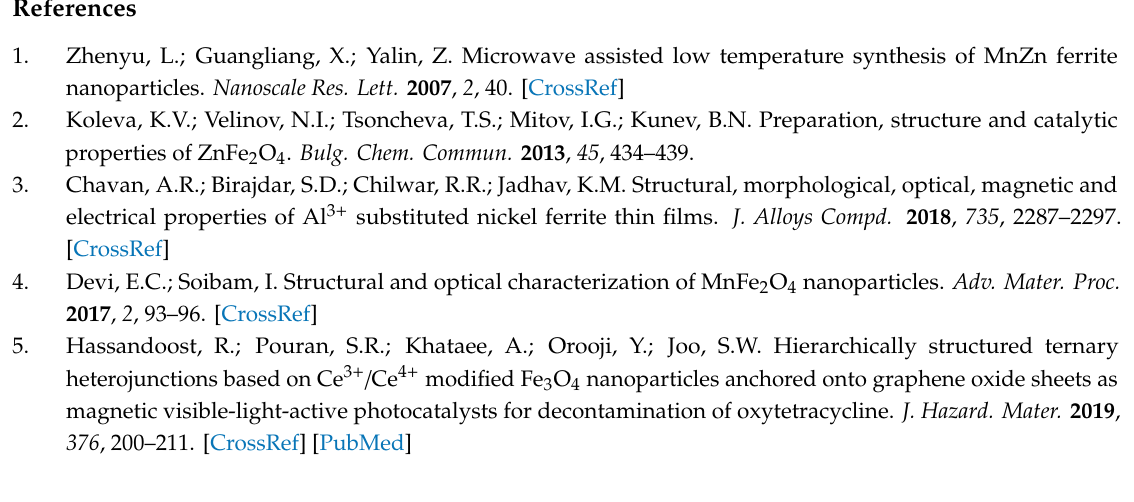
and COH, Figure S4: EDX spectrum of MnFe 2 O 4 , Table S1: Magnetic moment for Mn-ferrite and